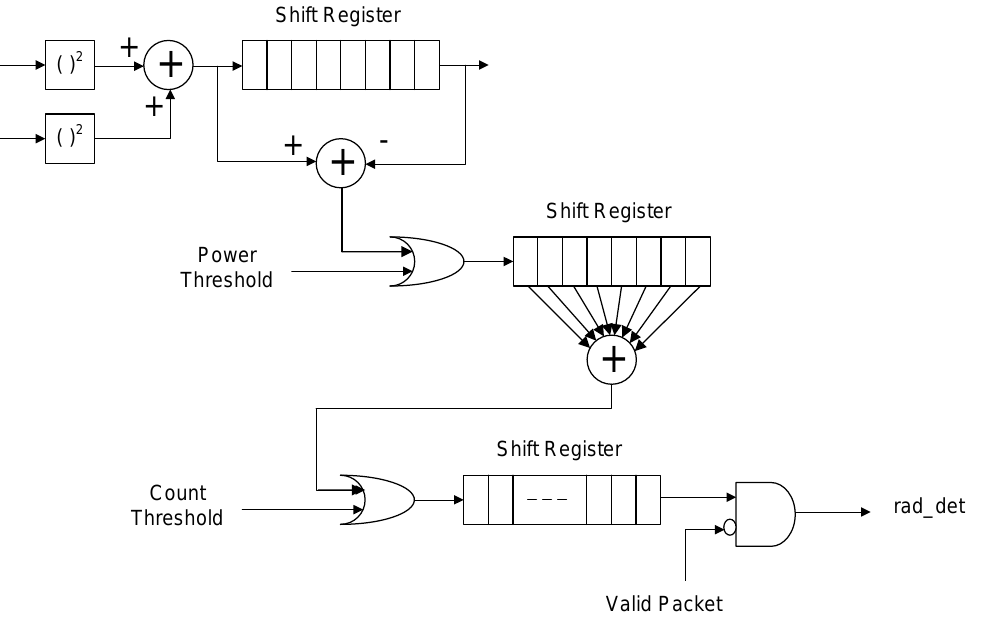
Figure 2. Block diagram of periodic an interference detector.